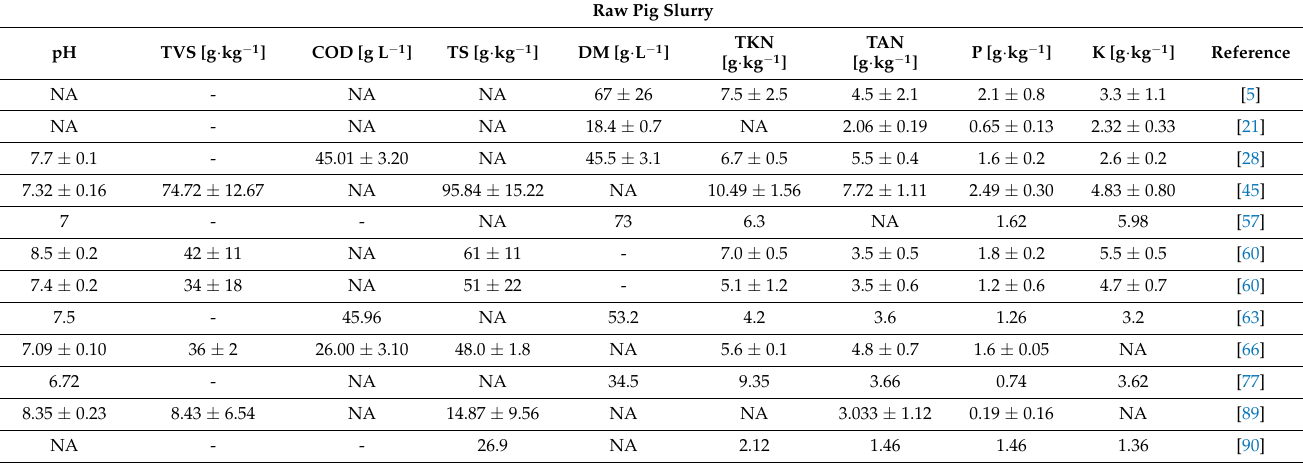
Table 3. Composition of raw pig slurry and separated raw pig slurry. Raw Pig